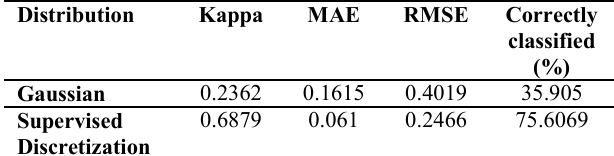
Table 3. Kappa statistic for each algorithm across all datasets when using a two-tailed significance of 0.001 and 10-fold cross-validation